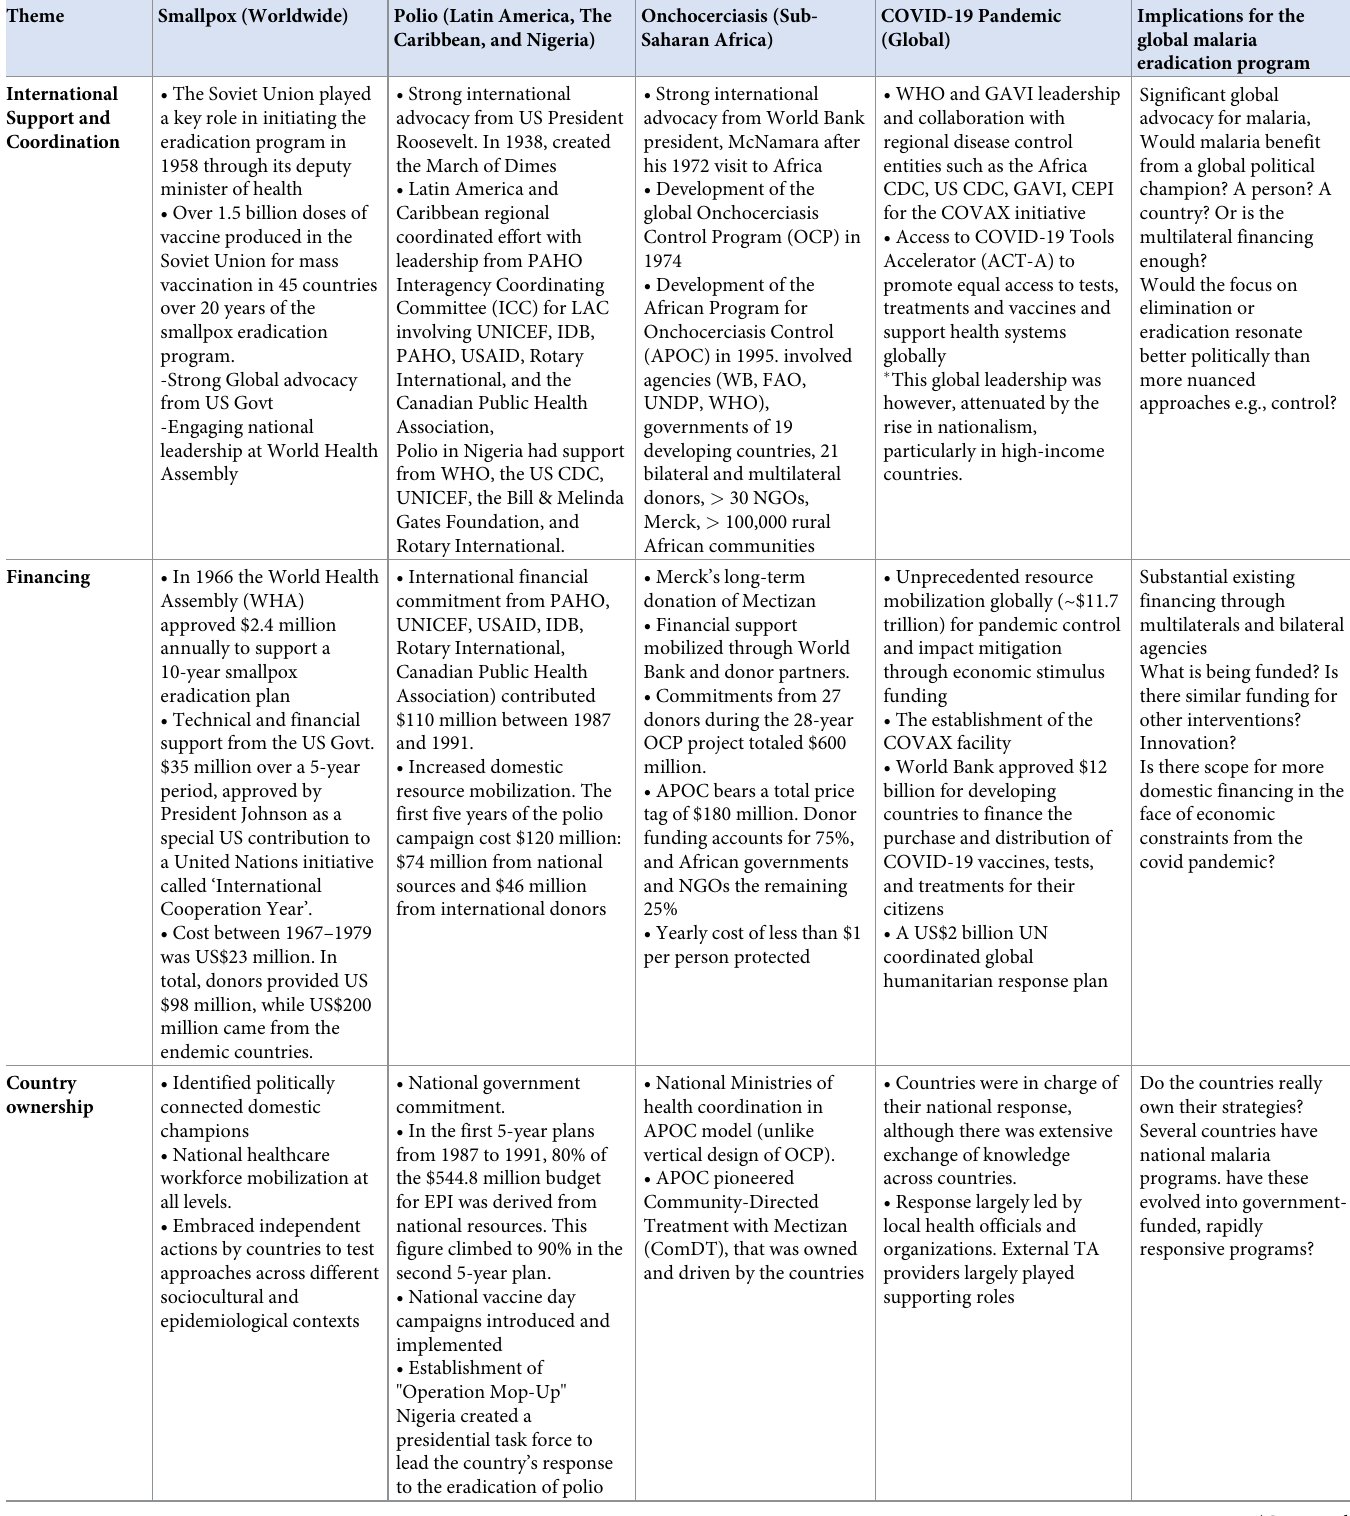
Table 2. A conceptual framework of factors associated with success of smallpox, polio, and onchocerciasis and COVID-19 disease programs. Theme Smallpox